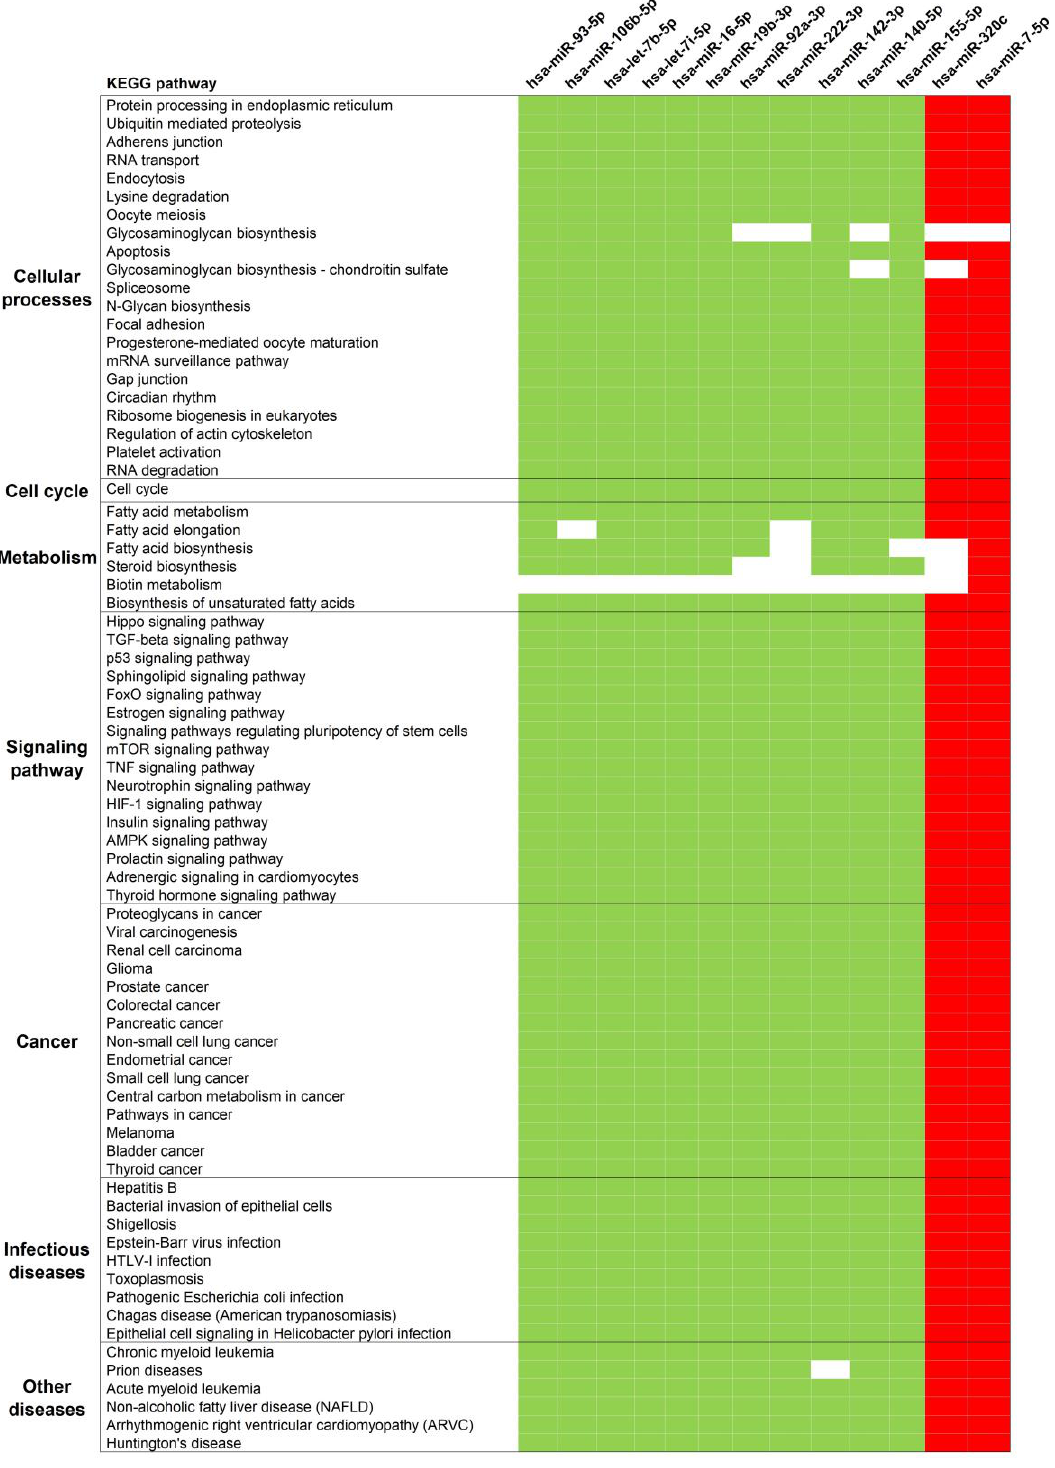
Figure 2. Significantly enriched KEGG pathways of surgery-responsive miRNAs. The miRNAs reported to be involved in a particular pathway are indicated in colors green or red; otherwise, they are indicated as white. Green indicates pathways targeted by down-regulated miRNAs. Red indicates pathways targeted by up-regulated miRNAs.